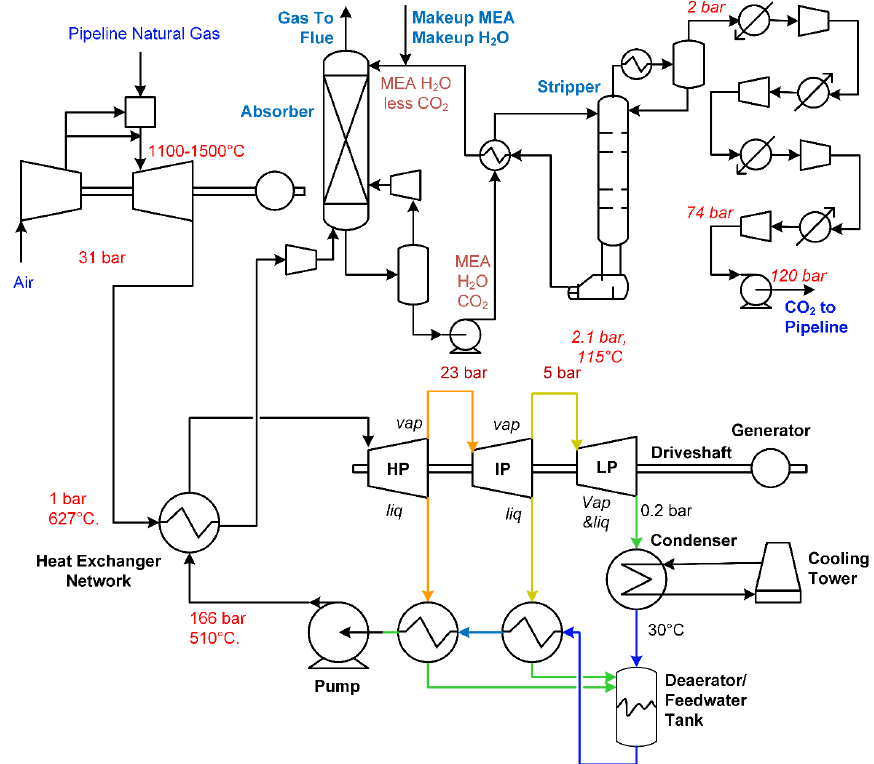
Figure 2. A typical natural gas combined cycle (NGCC) process with post ‐ combustion carbon capture for an example system using monoethanolamine (MEA) as a solvent. Adapted from a combination of